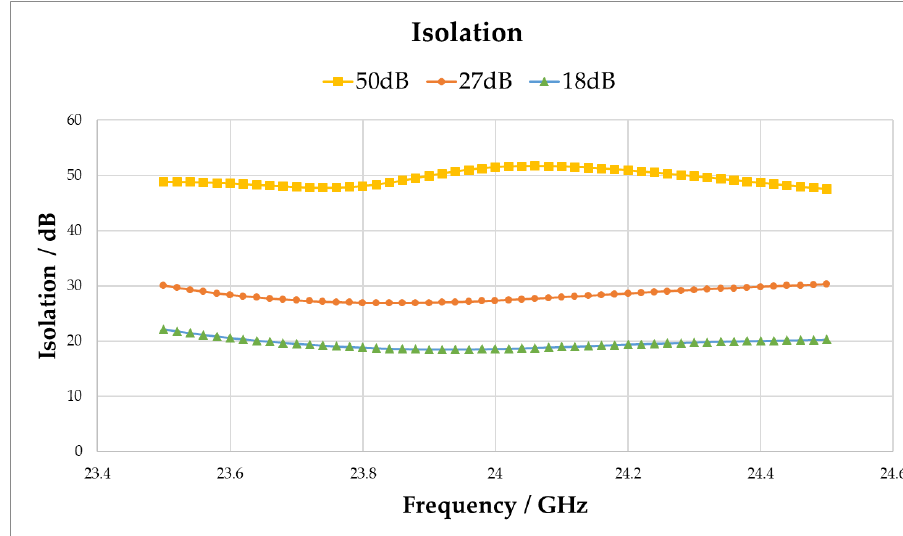
Figure 4. Three different isolation levels.